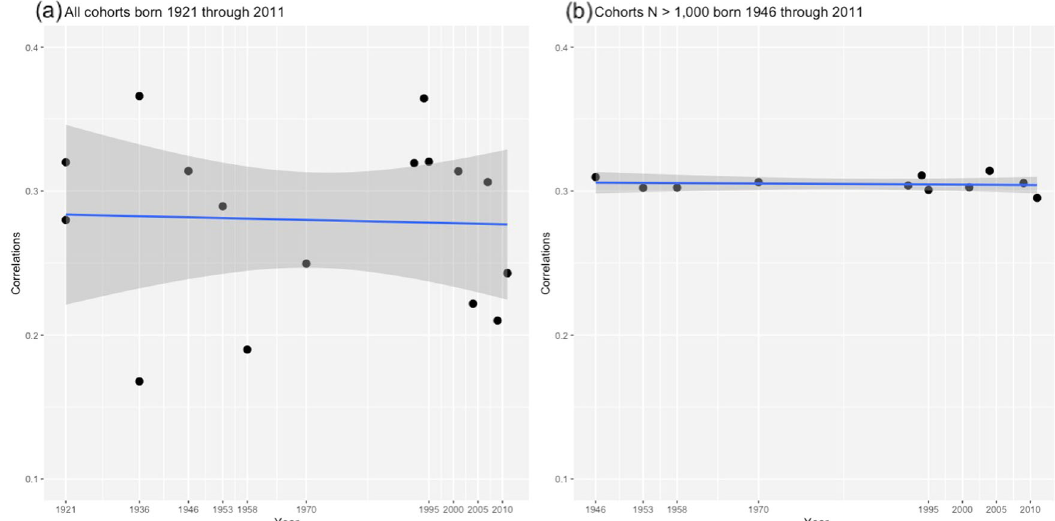
Fig. 3 Linear trends in the association between family SES and children ’ s school performance. Note. Estimates are based on the model fi tted to all cohorts ( a ) and the model fi tted to cohorts with N > 1000 only ( b ).